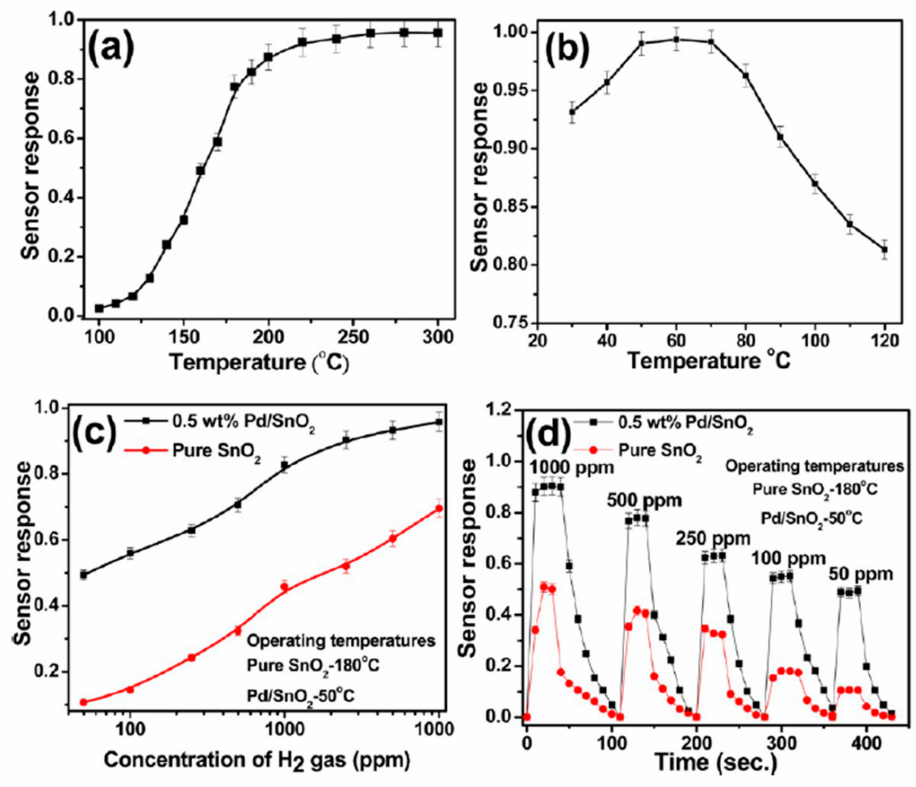
Figure 30. ( a ) Sensor response of pure SnO 2 at various working temperatures to 1% H 2 gas; ( b ) sensor response of Pd/SnO 2 at different temperatures to 1% H 2 gas; ( c ) sensor response of pure SnO 2 and Pd/SnO 2 toward various concentrations of H 2 gas at operating temperatures of 180 and 50 ◦ C, respectively; ( d ) Sensor response of pure SnO 2 and Pd/SnO 2 as a function of time at 180 and 50 ◦ C. reprinted from Ref. [219] with permission of the American Chemical Society,